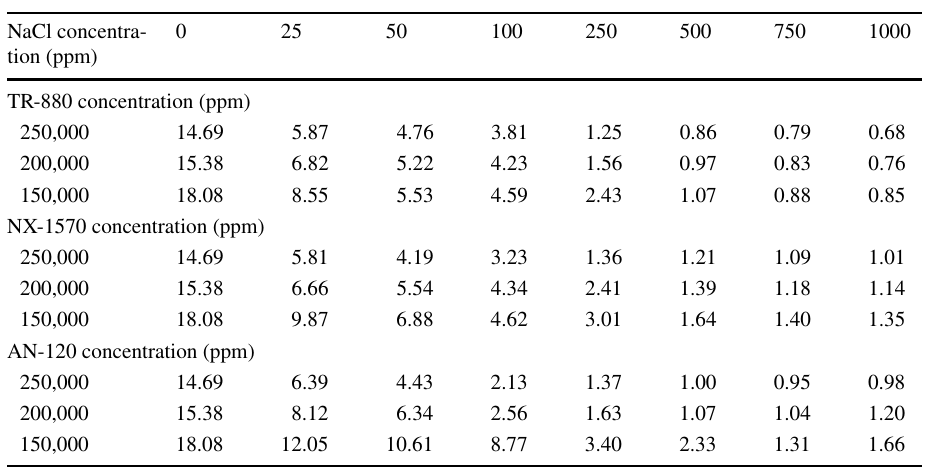
Table 5 Interfacial tension values of AN-120, NX-1510 and TR-880 surfactant solutions at different concentrations with NaCl solution in high concentrations and crude oil in mN/m at 351.15 K and pressure of 14.7